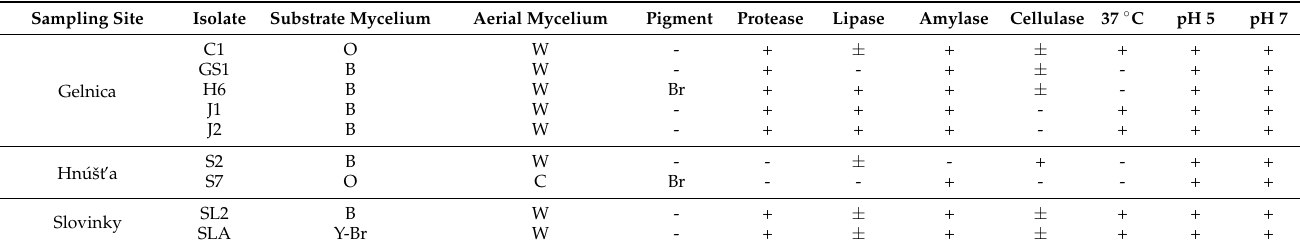
Table 1. Morphological characteristics of selected isolates, enzyme production and growth characteristic. Sampling